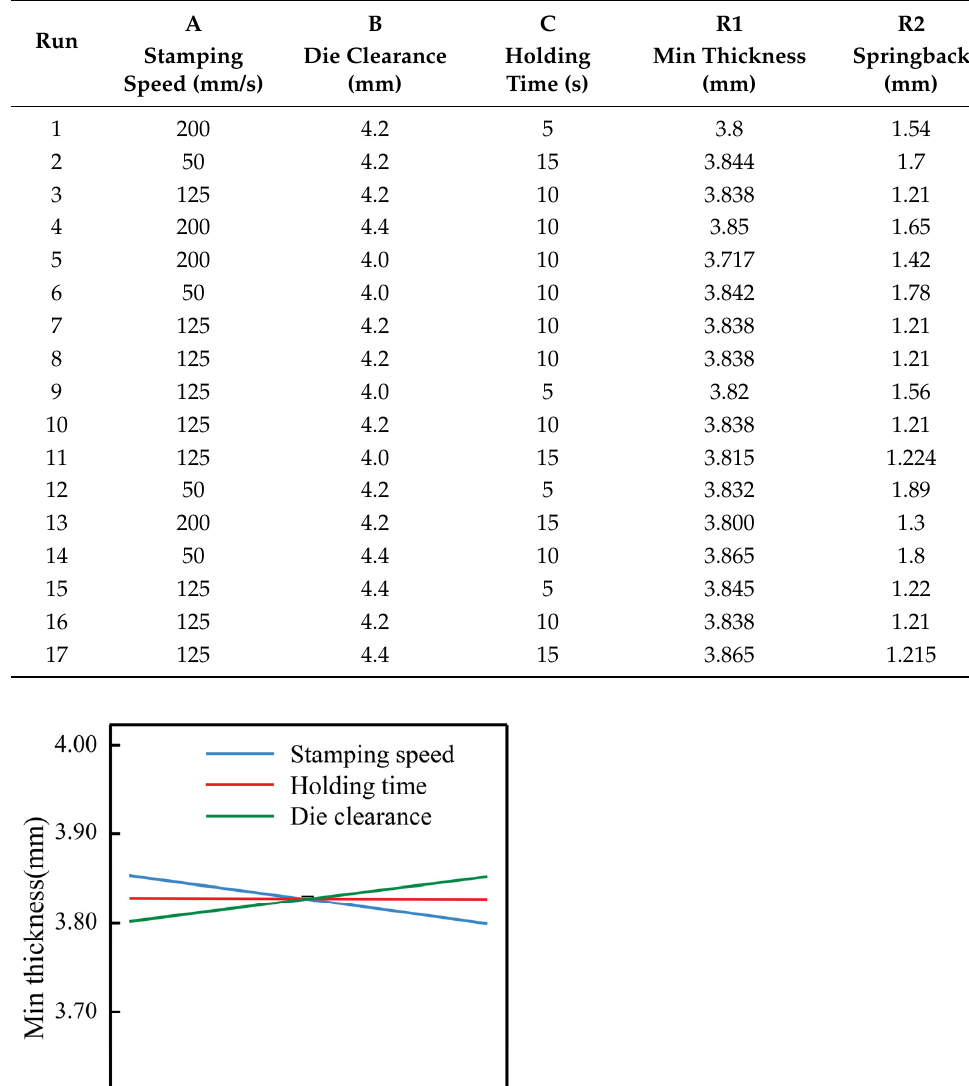
Table 2. Experimental design and results.